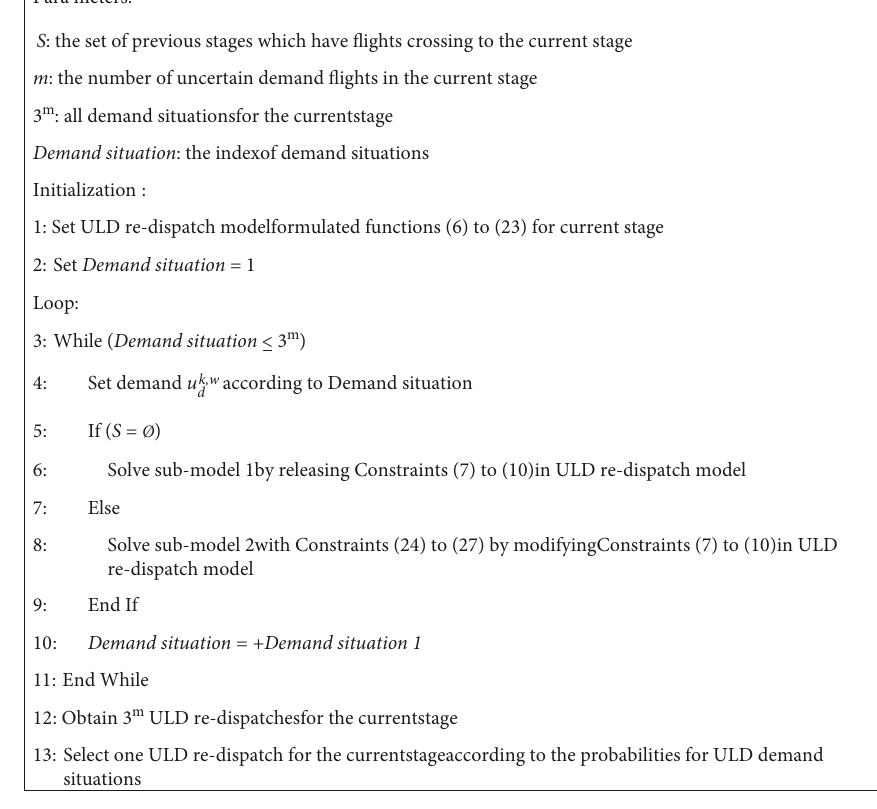
Figure 9: The pseudo-code for solving the ULD redispatch model for a